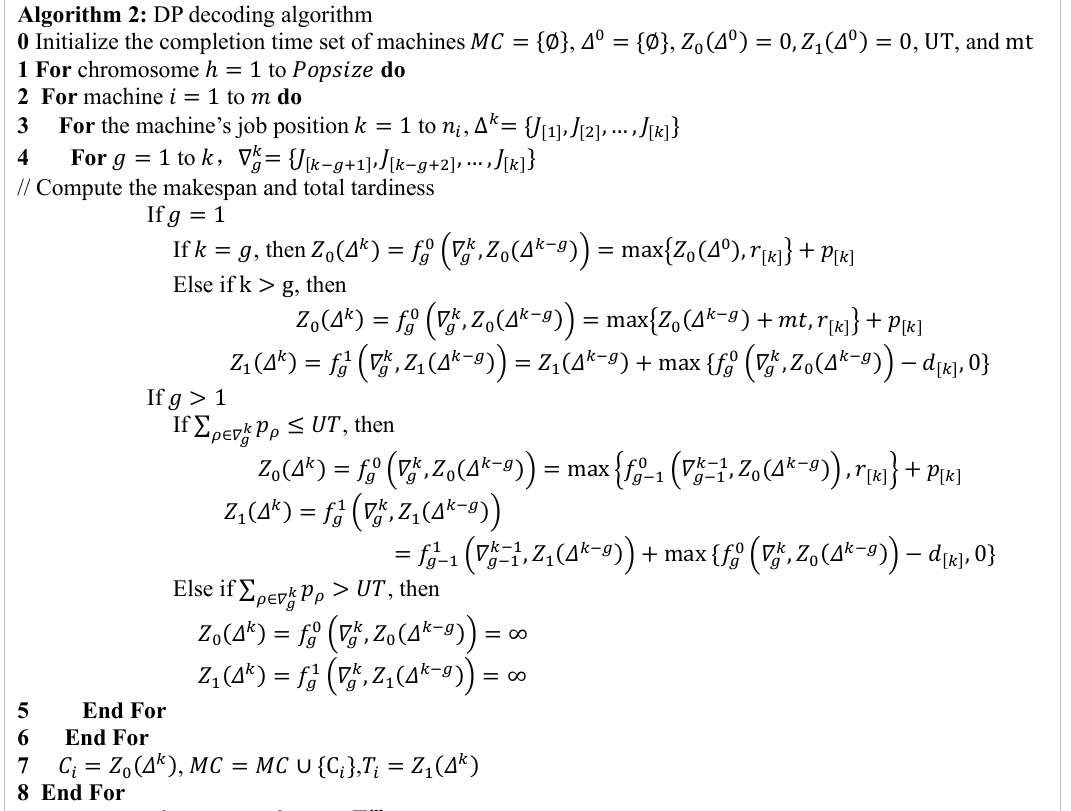
Algorithm 2: DP decoding